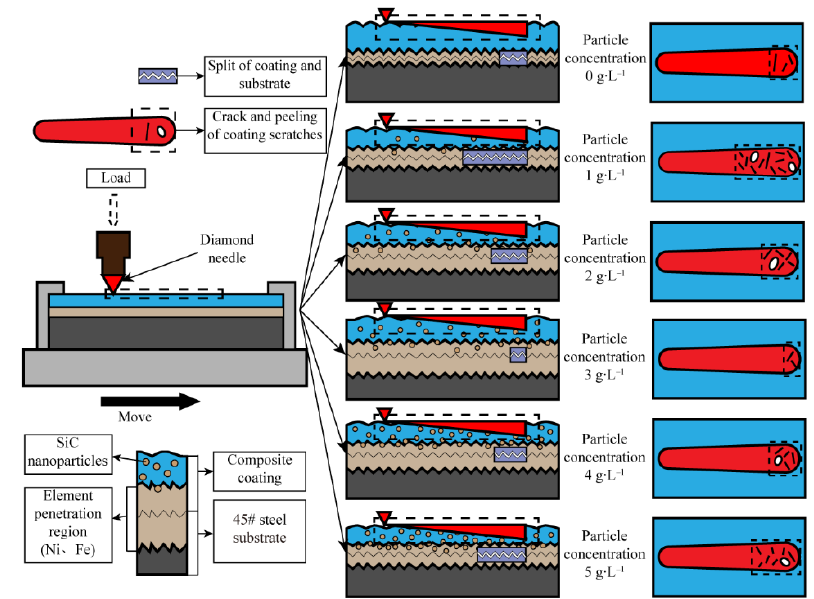
Figure 9. Schematic of the adhesion mechanism based on element penetration for the composite coatings with different particle concentrations prepared on 45 steel substrates through scanning electrodeposition.